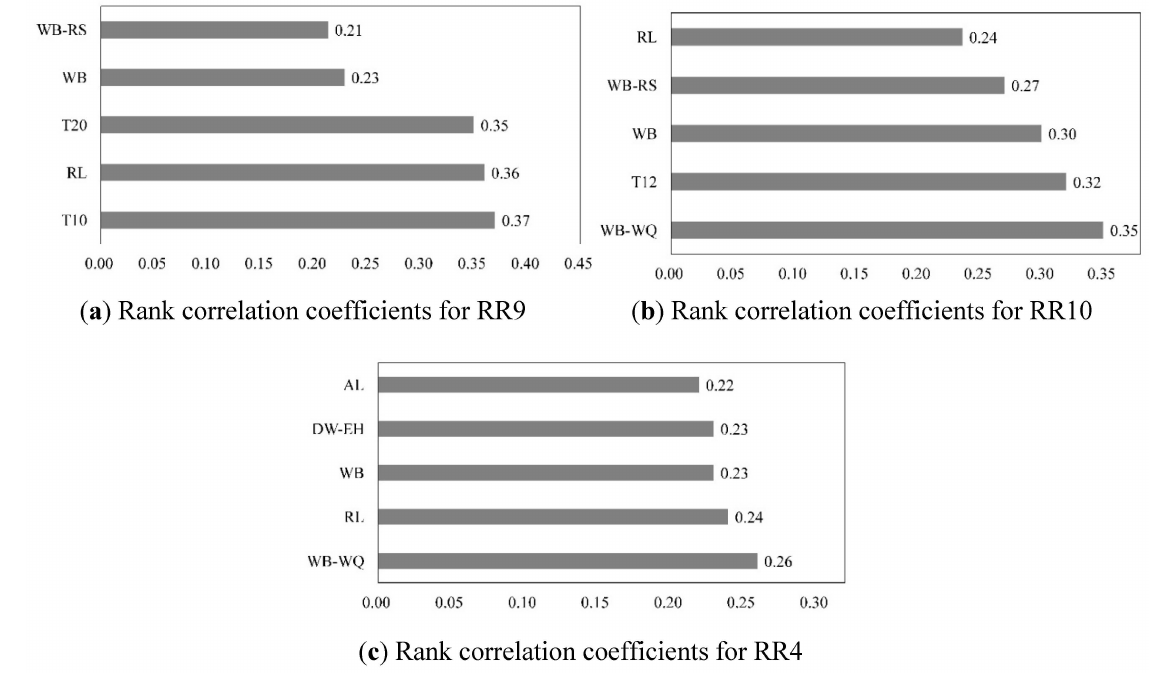
Figure 8. Rank correlation coefficients for different regions. The abbreviations on the y-axis relate to essential factors of assessment and are defined as follows: WB-RS and WB-WQ are effect filters of water body to residential safety and water quality, respectively; WB is water body; RL is residential land; T10 and T20 are mine tailings ponds; AL is agricultural land;. DW-EH is an effect filter of drinking water intake to ecosystem